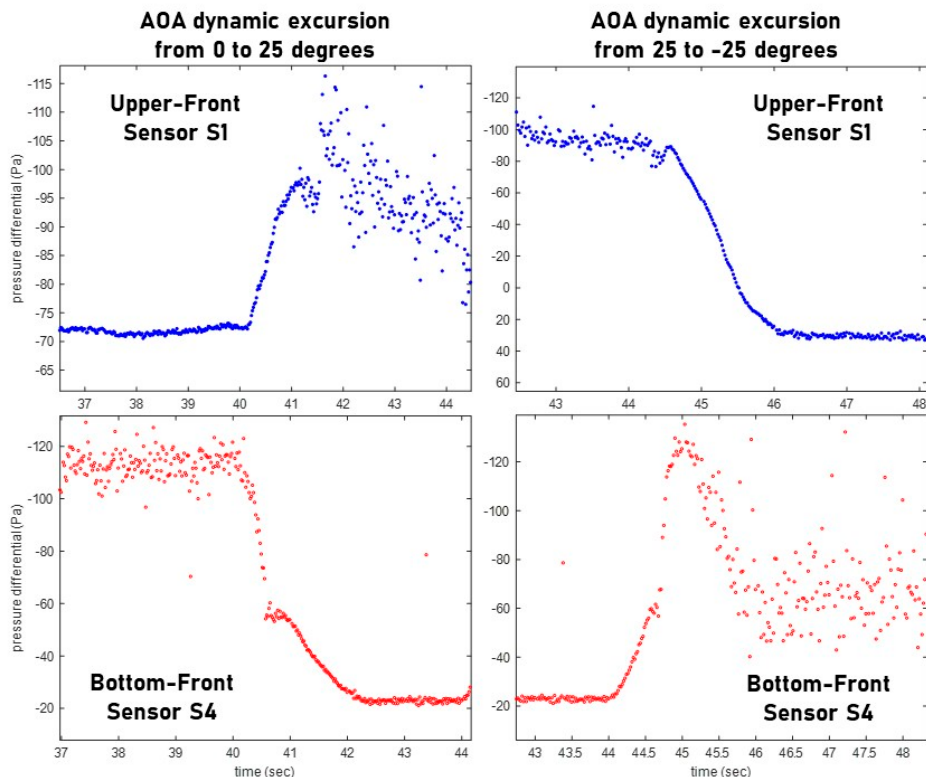
Figure 4. Dynamic AOA excursions at an air speed of 10 m/s.